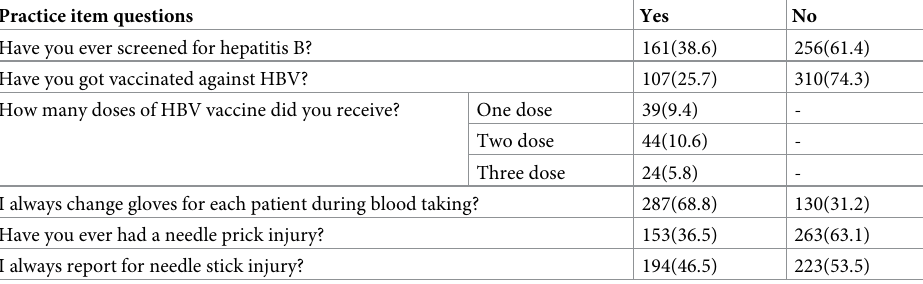
Table 4. Practices of medicine and health sciences students towards hepatitis B prevention at the Wolkite Univer- sity, 2020 (n = 417). Practice item